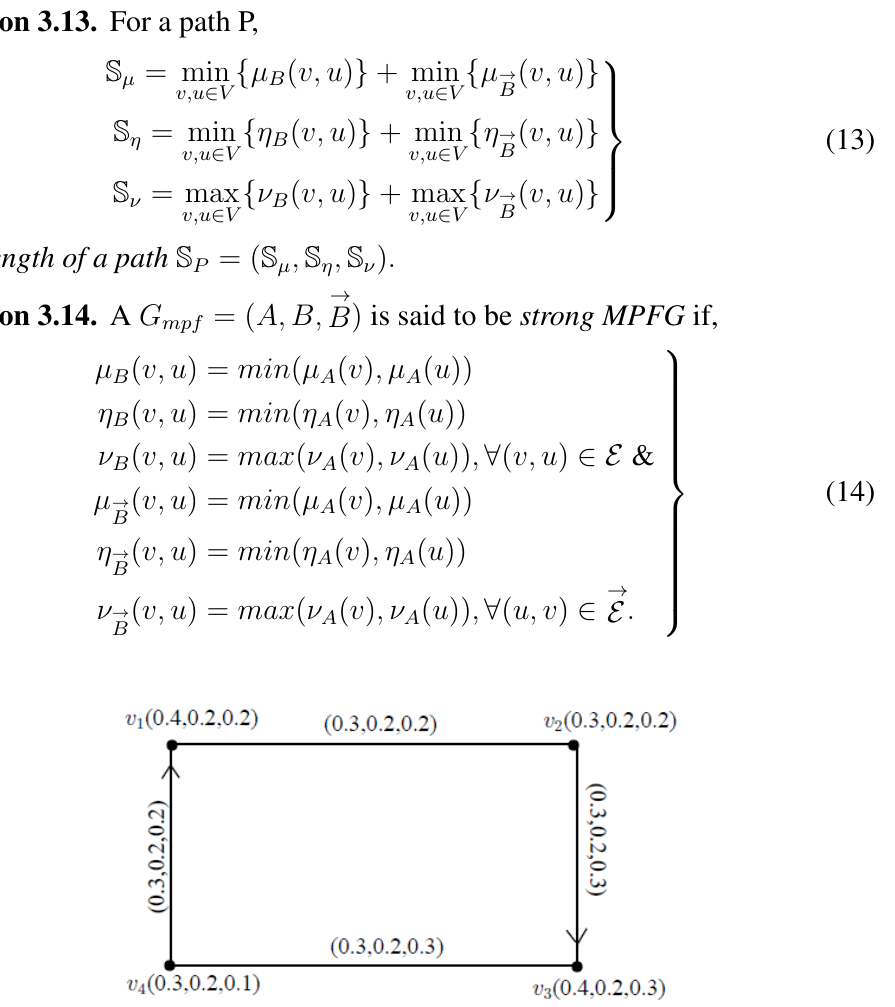
Figure 3: Strong Mixed Picture Fuzzy